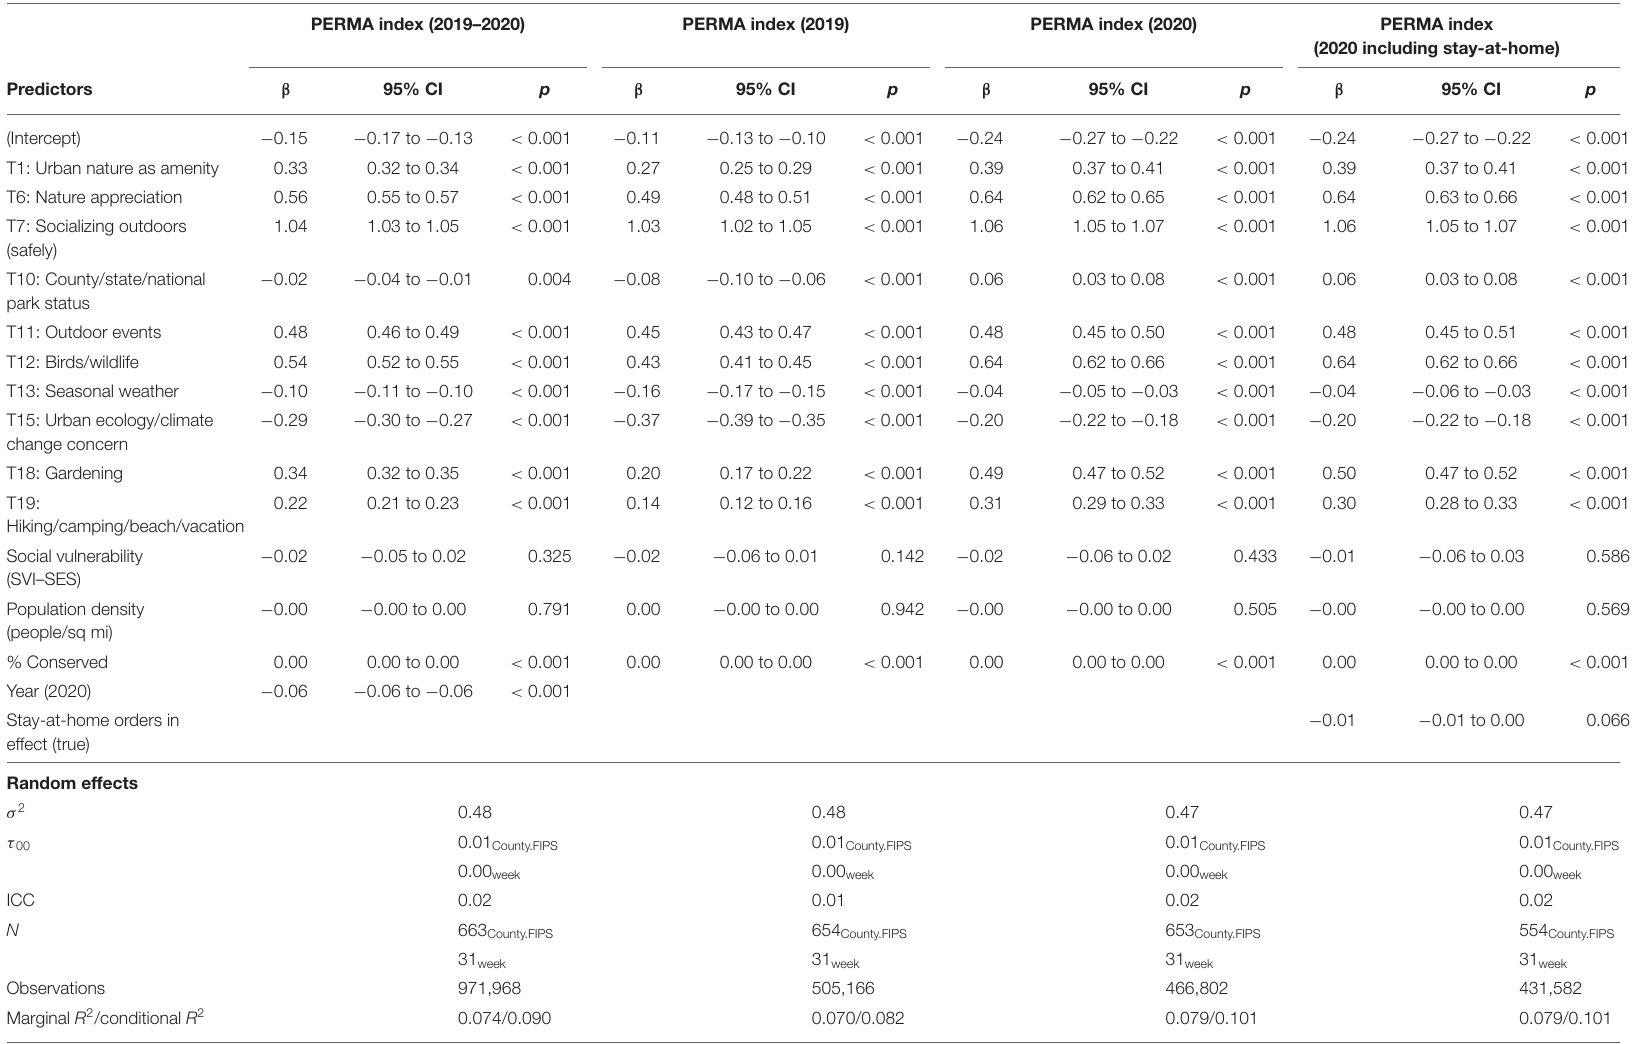
TABLE 4 | Mixed-effects model results for overall PERMA index for (a) 2019 and 2020 tweets, (b) 2019-only tweets, (c) 2020-only tweets, and (d) 2020-only tweets including stay-at-home orders, reporting 95% confidence intervals